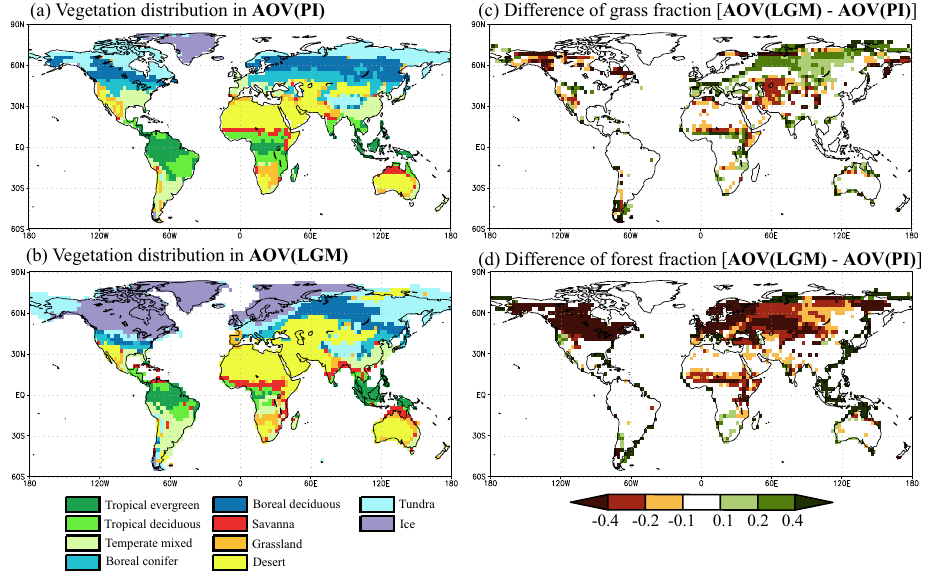
Fig. 1. Vegetation distribution obtained in (a) AOV(PI) and (b) AOV(LGM) according to MATSIRO classification. Difference of fractional coverage in (c) grass and (d) forest between AOV(LGM) and AOV(PI) which are from PFT-based variables in the LPJ-DGVM.